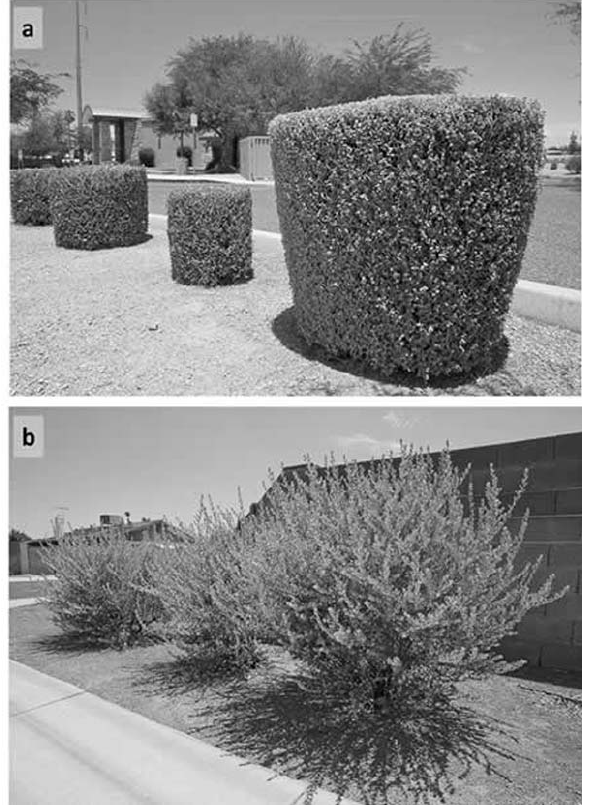
Fig. 5. Example of the variation in landscaping activities. (a) Typical pruned shrub in residential yards in Phoenix, Arizona. (b) A similar shrub, unpruned. Allowing shrubs to grow out could have beneficial implications for arthropod